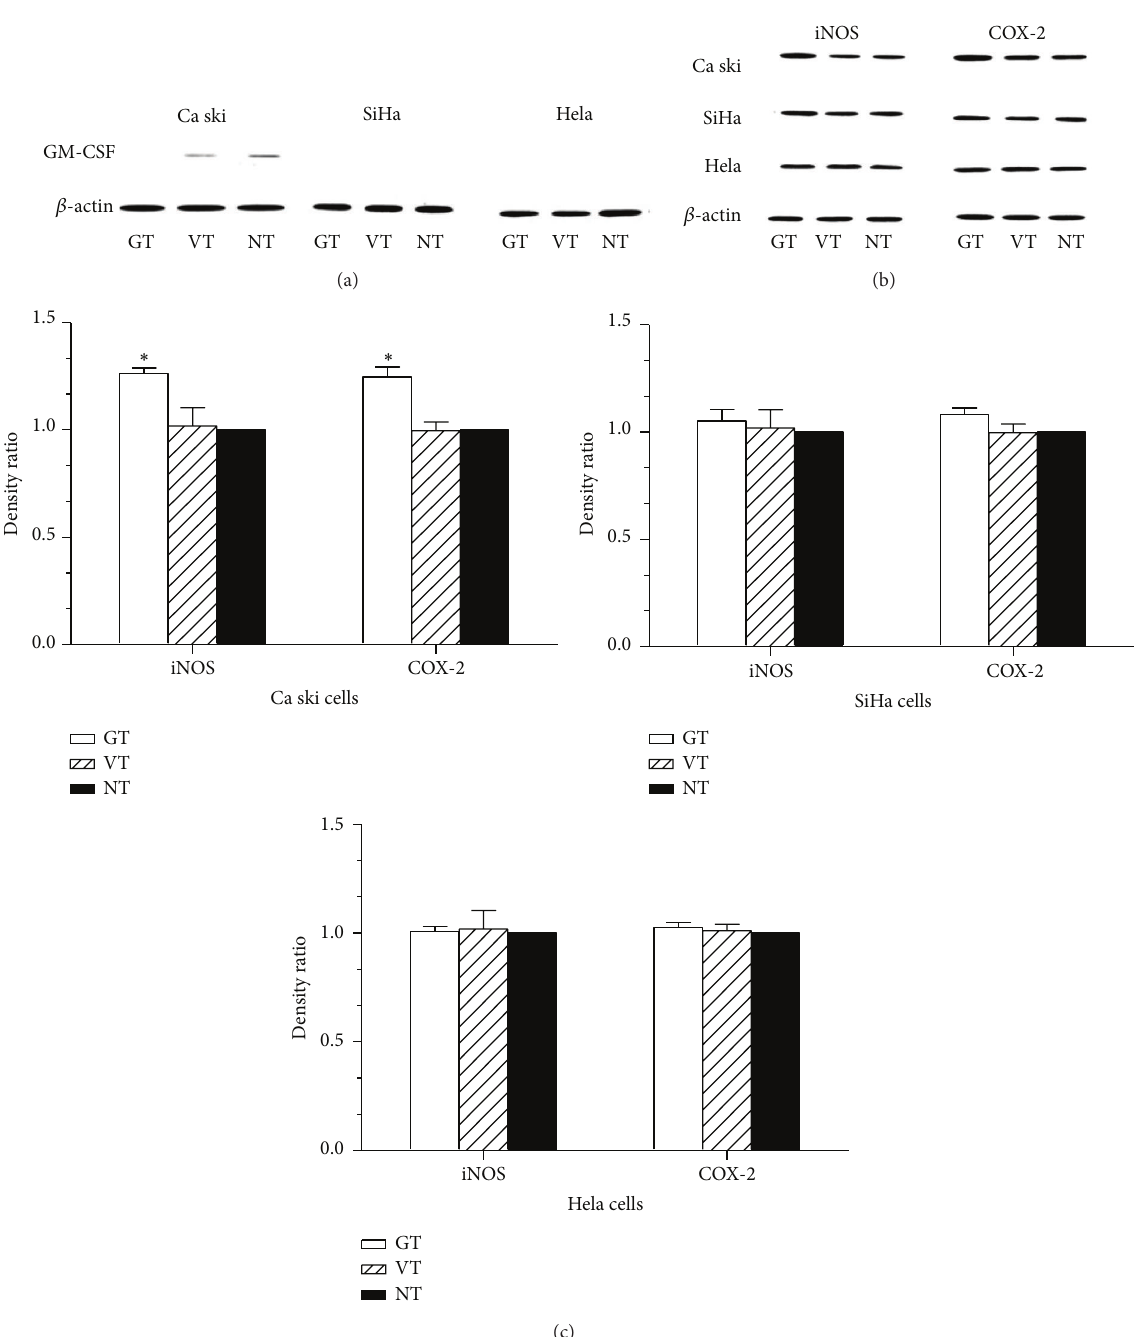
Figure 4: Knockdown of GM-CSF upregulates iNOS and COX-2 expression. (a, b) Western blot analysis of Ca Ski, SiHa, and Hela cells transfected with siRNA targeting the GM-CSF gene to detect the expression of GM-CSF (a), iNOS and COX-2 (b), respectively. (c) Unpaired Student’s 𝑡 -test was used to detect the differences of iNOS and COX-2 expression in different groups. Each experiment was repeated three times. GT: GM-CSF siRNA transfection, VT: scrambled siRNA transfection, and NT: nontransfection ∗ 𝑝 < 0.05 versus NT group. Error bars represent mean ±